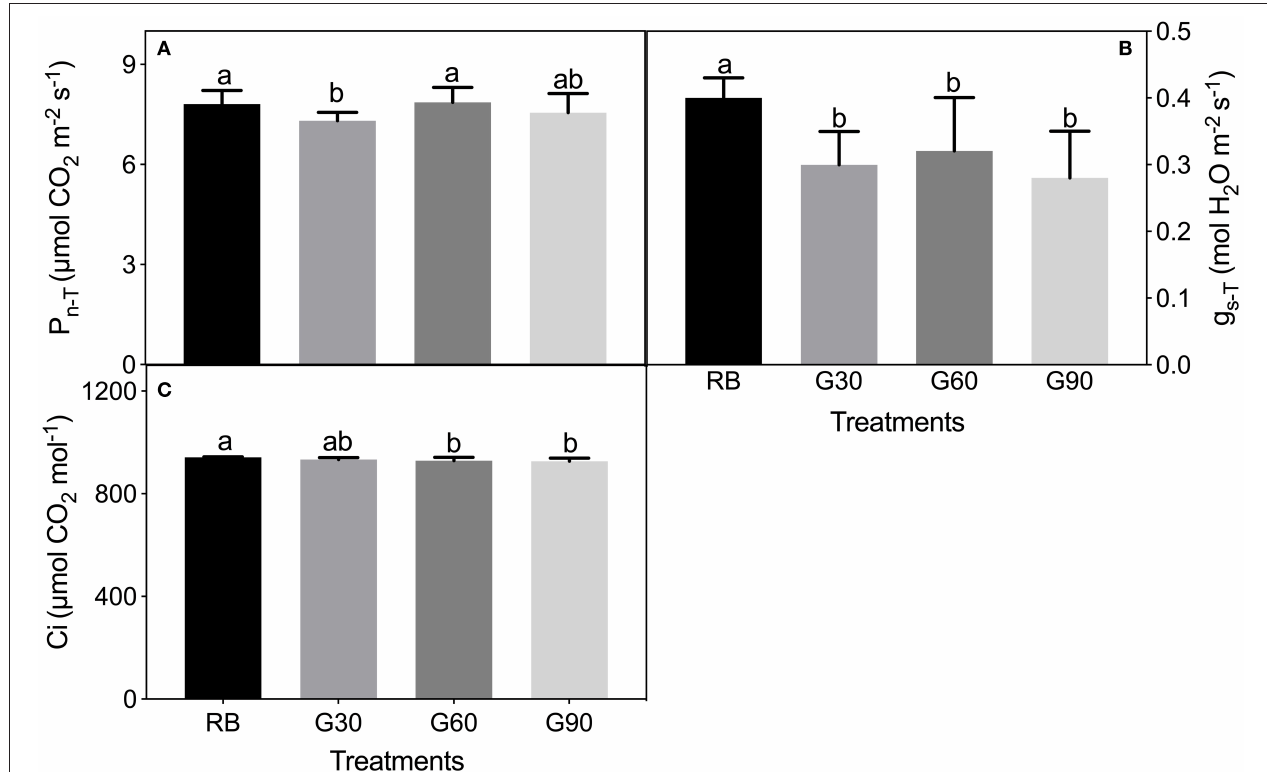
FIGURE 8 | P n − T (A) , g s − T (B) , and Ci (C) under the actual light condition of lettuce leaves as affected by different proportions of green light. Different letters in each column indicate significant differences at p < 0.05, according to the least significant difference (LSD) test.